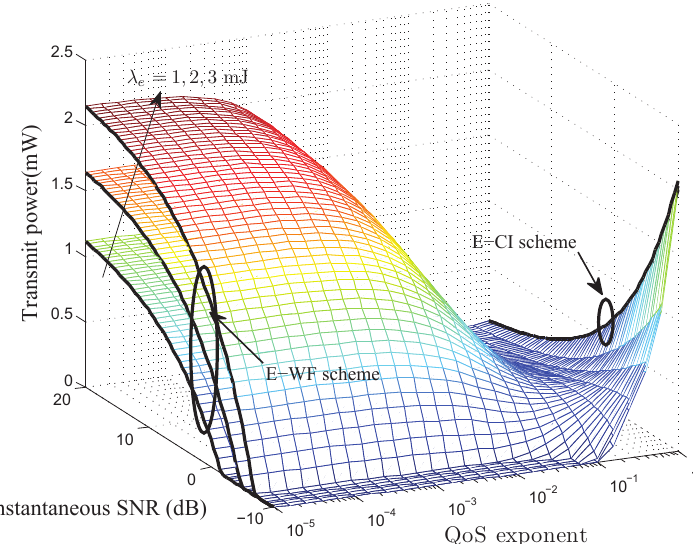
Figure 2. The QoS-driven power control policy for battery-infinite energy harvesting based wireless sensor networks with m = 2 and γ = 5